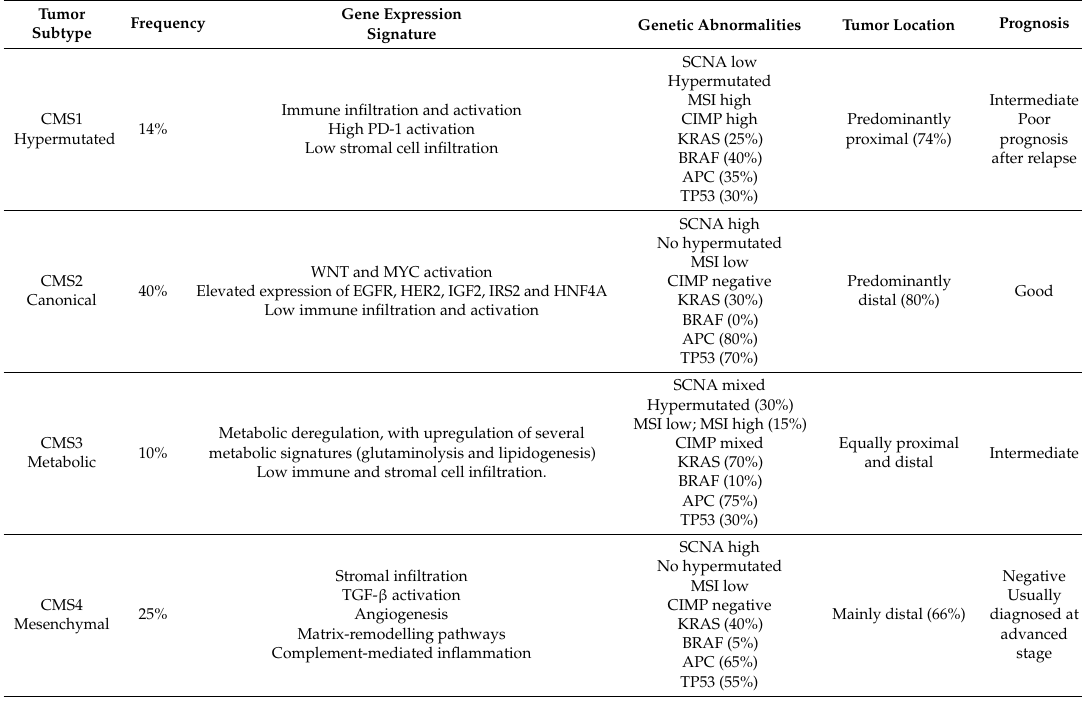
Table 1. The gene expression-based consensus molecular classification of colorectal